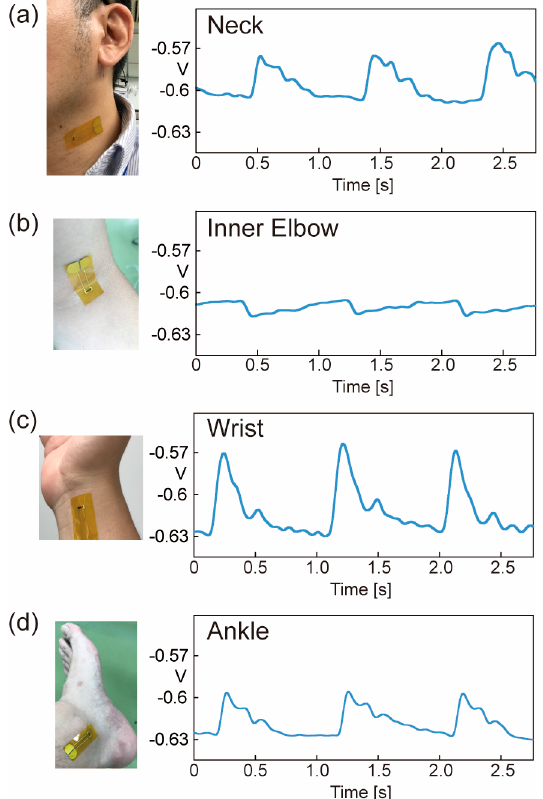
Figure 8. Demonstration to measure blood pulse with our fabricated film-type sensor at ( a ) neck, ( b ) inner elbow, ( c ) wrist, and ( d ) ankle.